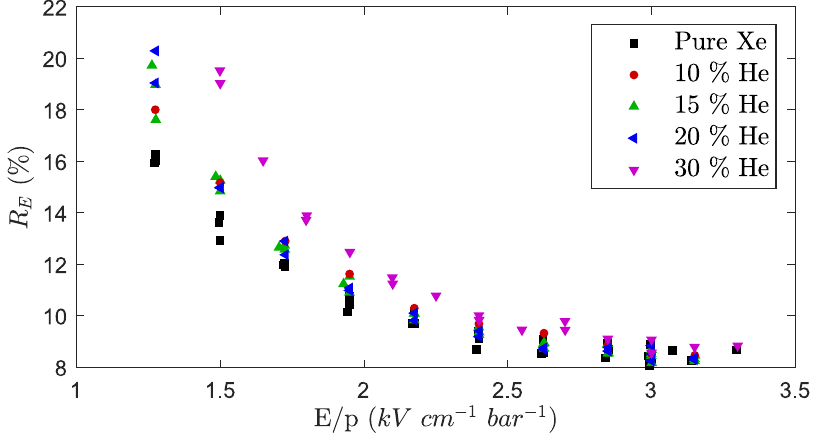
Figure 10 . Energy resolution as a function of reduced electric (cid:12)eld in the EL region, obtained for pure xenon and the di(cid:11)erent Xe-He mixtures studied in this work. A relative statistical error of 3% was calculated for several measures having the same working